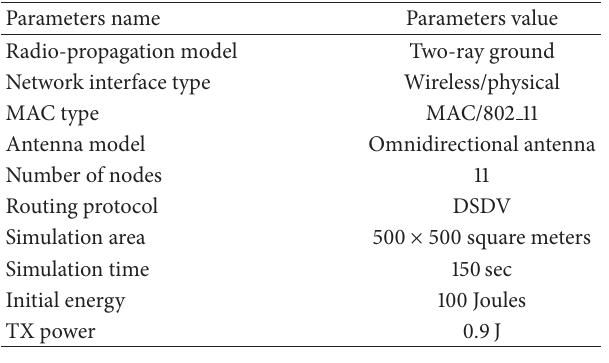
Table 1: Simulation parameters.